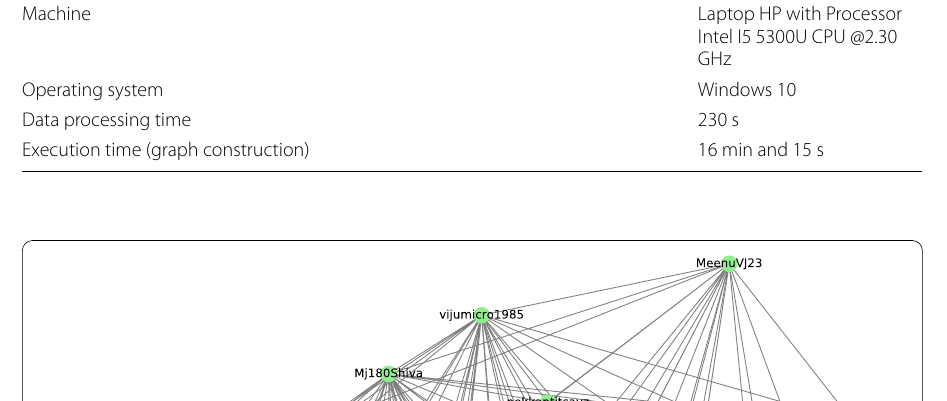
Table 5 The time complexity for data processing and the exact execution time for 1 MB data